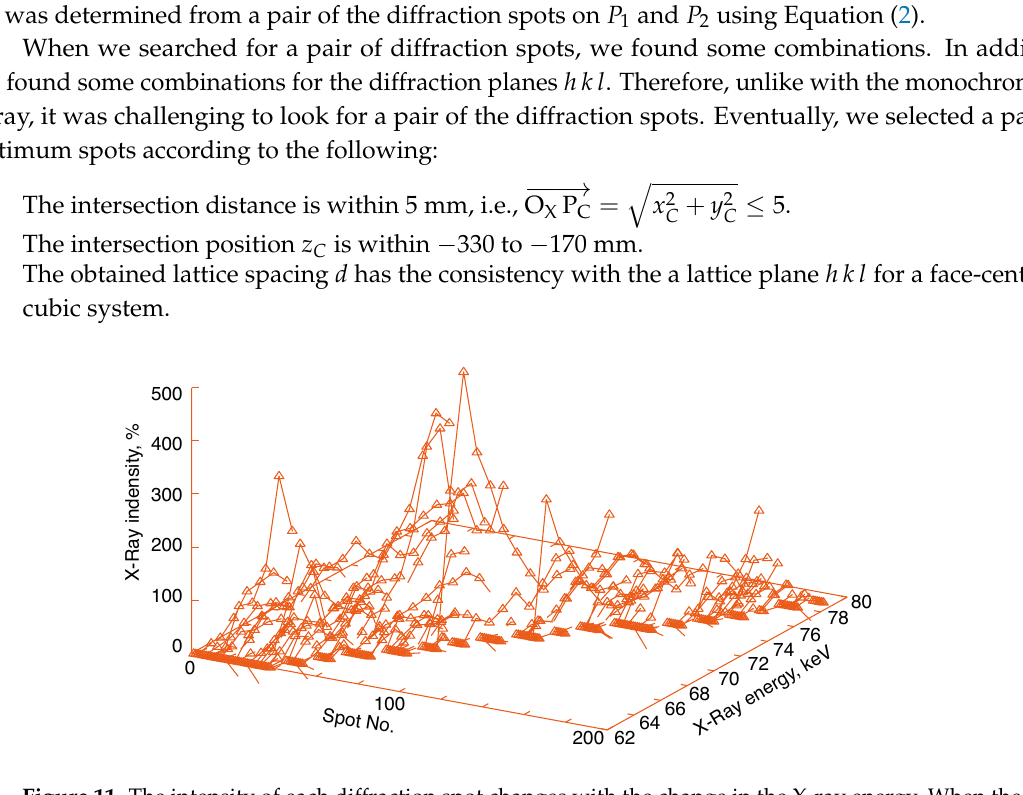
Figure 11. The intensity of each diffraction spot changes with the change in the X-ray energy. When the intensity is the maximum, the diffraction condition for the spot is the most suitable for Bragg’s